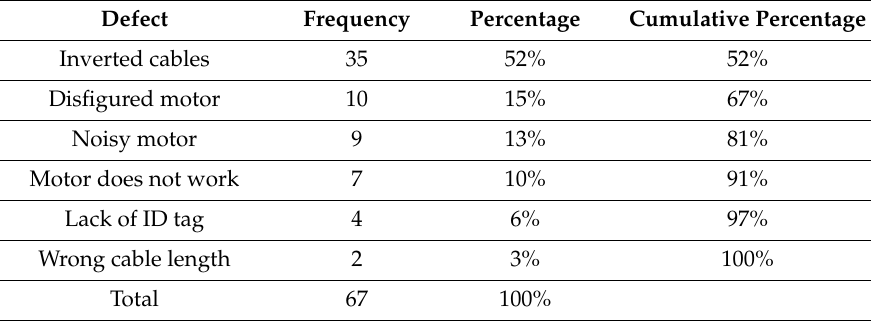
Table 4. Defects found in the rejected cable